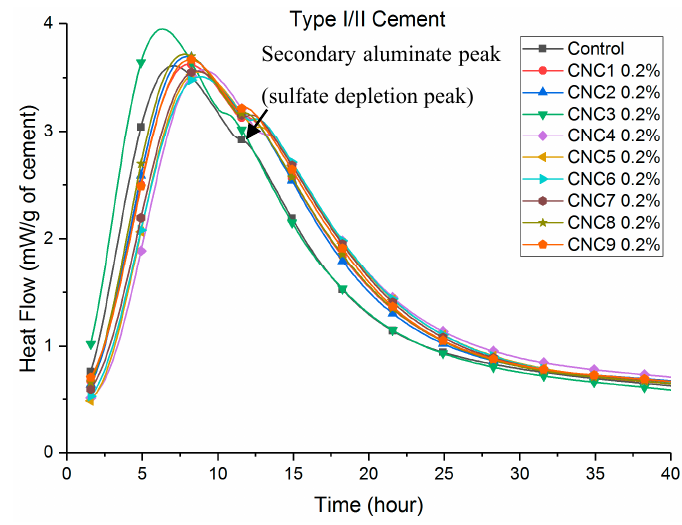
Figure 2. Heat flow of Type I/II cement, different CNCs.